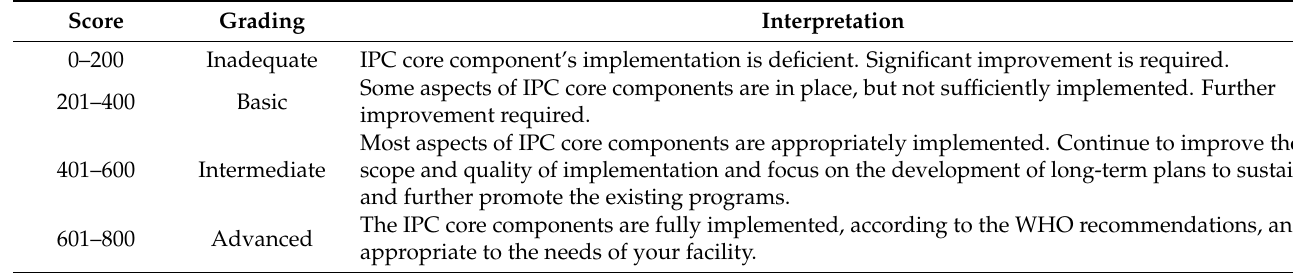
Table 1. IPCAF scoring interpretation.